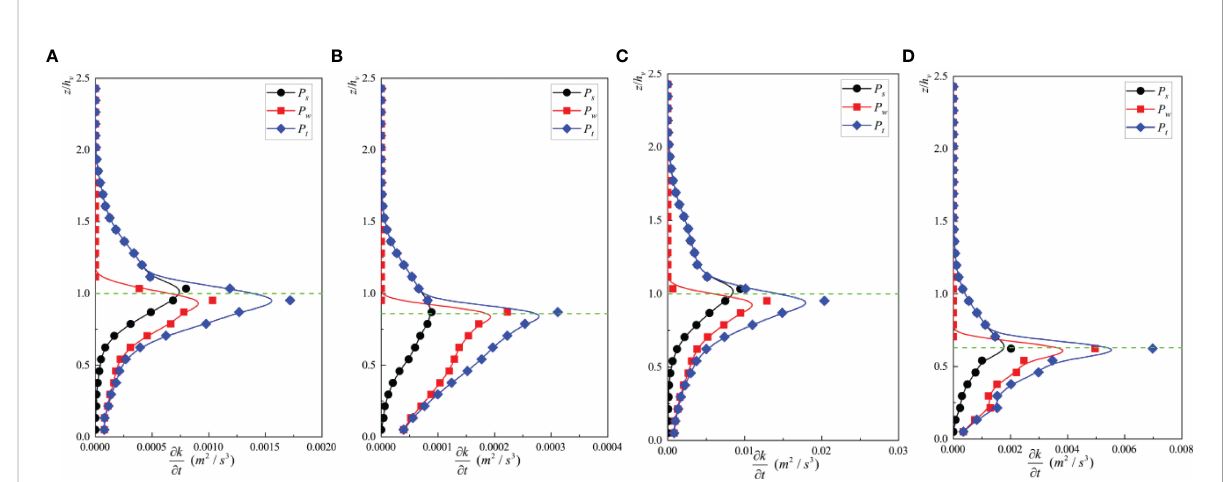
FIGURE 11 Vertical distributions of the shear production term, P s , the wake production term, P w , and the total production term, P t , of turbulent kinetic energy under (A) A1-5, (B) A1-1, (C) E1-5, and (D)